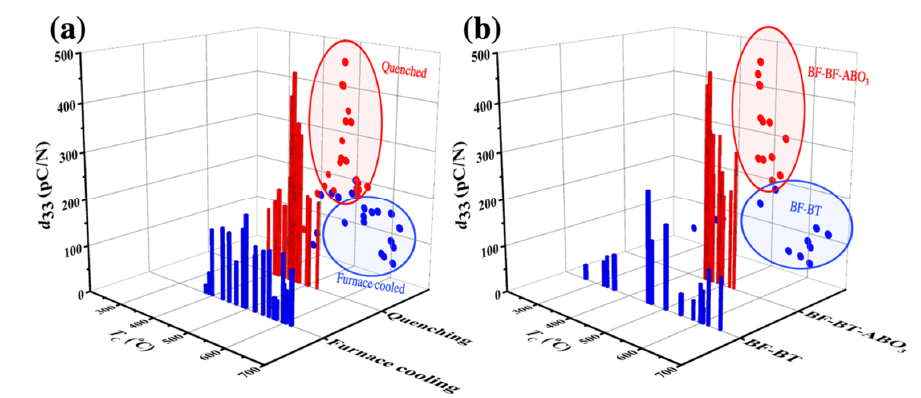
Figure 13. Piezoelectric coefficient d 33 versus Curie temperature in BF–BT-based system. ( a ) Com- parison between quenched ceramics and furnace cooled ceramics. ( b ) Comparison between BF–BT system and BF–BT– AB O 3 system [70,75,78,97–99,106–122].